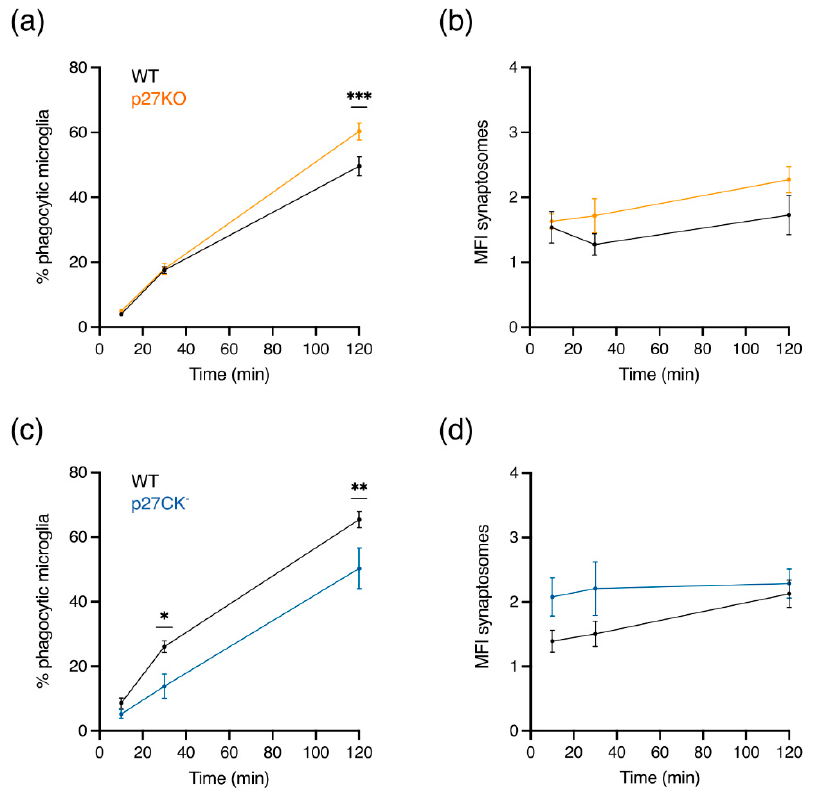
Figure 6. Primary microglia show a change in phagocytic capacity upon modulation of p27 expression. ( a , b ) The percentage of phagocytic microglia after 2 h incubation with DiI-labeled synaptosomes was significantly increased upon loss of p27 (p27KO) ( a ) but decreased after 30 min and 2 h incubation in the cell cycle dead variant of p27 (p27CK − ) ( b ). ( c , d ) The uptake (median fluorescence intensity, MFI) of DiI-labeled synaptosomes in phagocytic microglia did not significantly change upon loss of p27 ( c ) or a cell cycle dead variant ( d ) of p27. Sample size ( a , b ) for p27WT: 9/5 (brains/mothers); p27KO: 9/5. Sample size ( c , d ) for p27WT: 9/6; p27CK − : 5/6. Values are reported as mean ± SEM. * p < 0.05, ** p < 0.01, *** p < 0.001. Multiple Mann–Whitney U test.